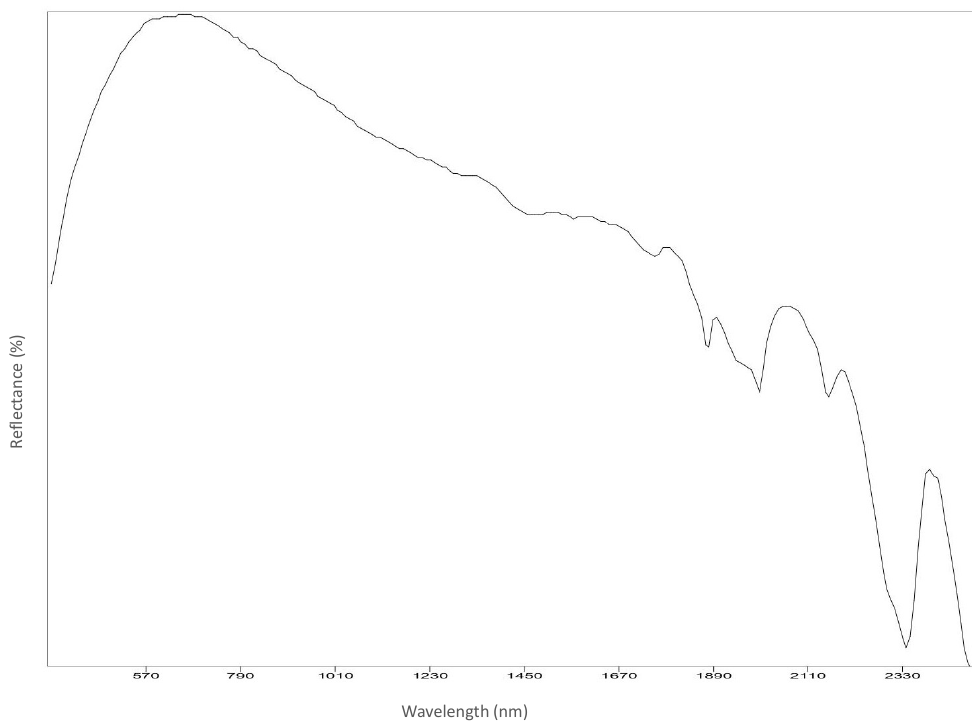
Figure A16. Forehead. Figure A16.